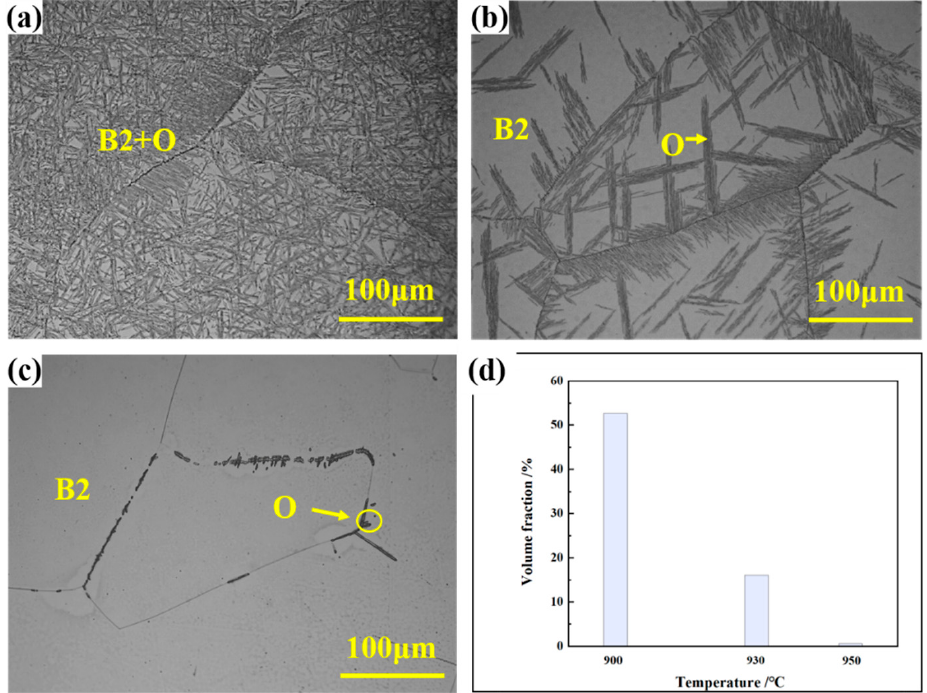
Figure 4. Microstructure of Ti-22Al-25Nb alloy held for 30 min at different temperatures. ( a ) 900 °C, ( b ) 930 °C, ( c ) 950 °C, ( d ) statistical results for the volume fraction of the orthorhombic (O) phase.